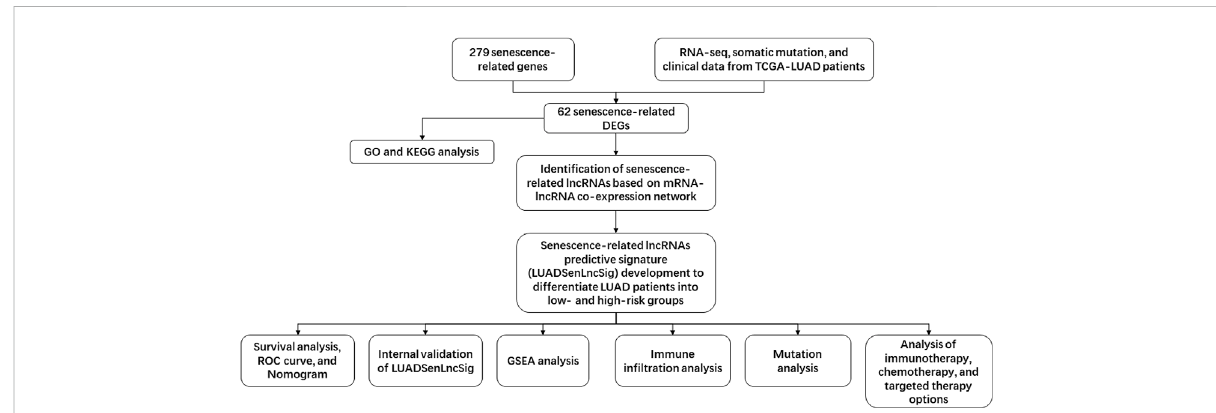
FIGURE 1 Flowchartof thepresentstudy. TCGA, The Cancer Genome Atlas; RNA-seq, RNA sequence; LUAD, lung adenocarcinoma; DEGs, differentially- expressed genes; GO, Gene Ontology; KEGG, Kyoto Encyclopedia of Genes and Genomes; lncRNAs, long non-coding RNAs; ROC, receiver operating characteristic; GSEA, Gene Set Enrichment